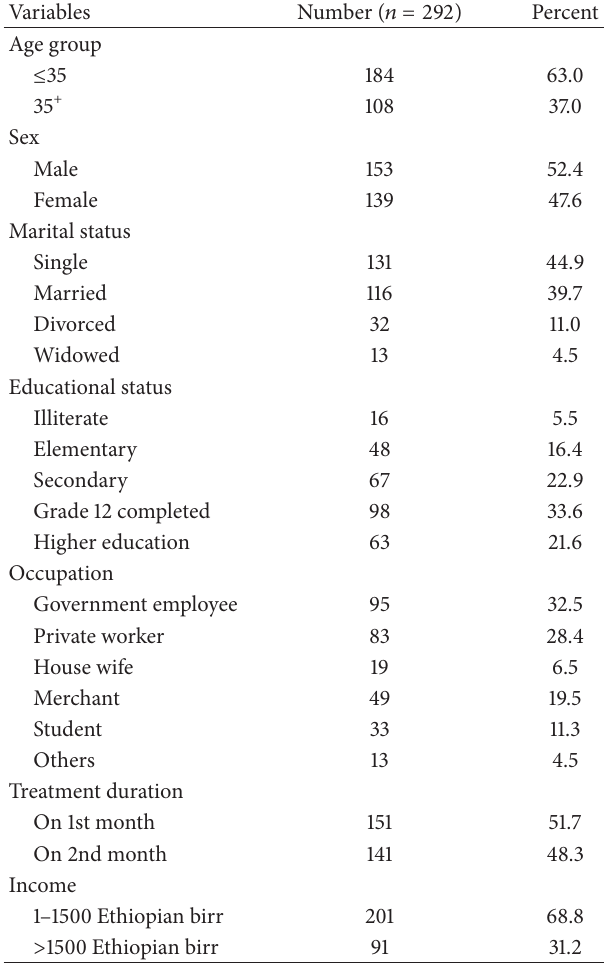
Table 1: Sociodemographic characteristics of TB patients in private health facilities of A. A,